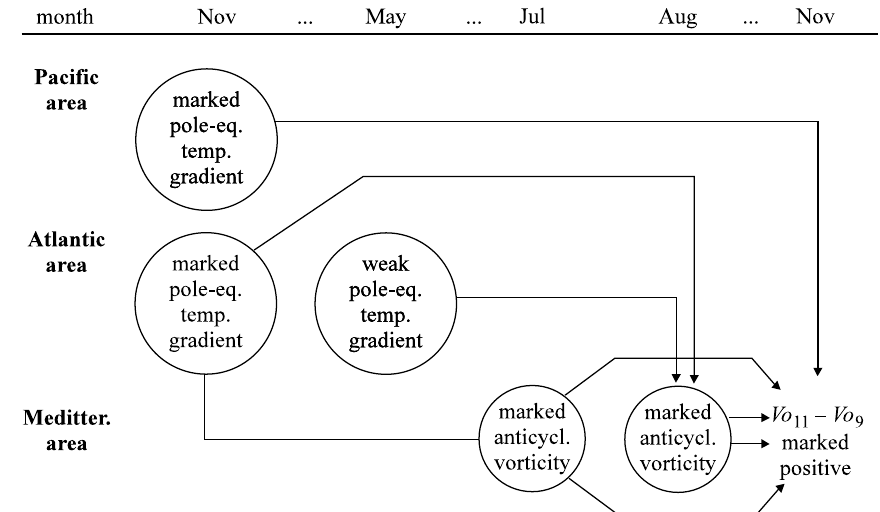
Table 5. Typical sequence of monthly features leading to a marked increase in cyclonic vorticity between September